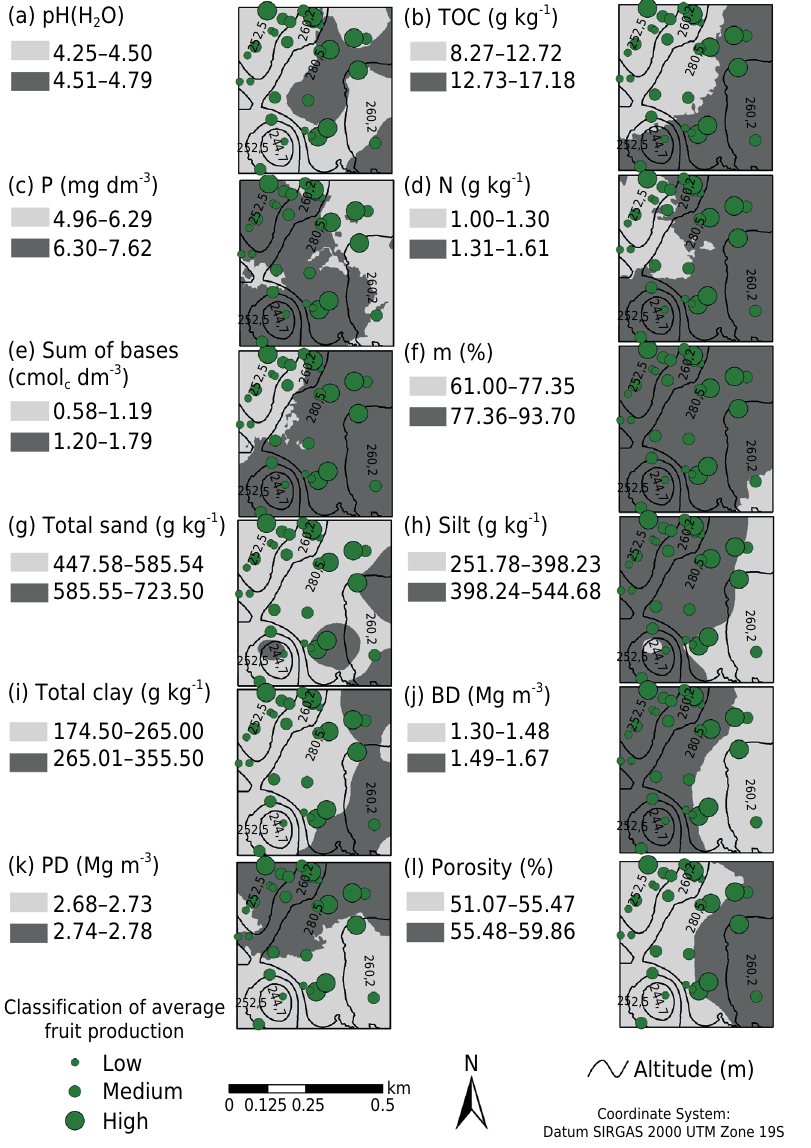
Figure 5. Spatial distribution of soil physical and chemical properties in Cachoeira - Plot 2, in the state of Acre, Brazil. Lines and values in the maps correspond to the altitude of the area, circles correspond to the average fruit production between the years 2010 and 2020, and values presented in the legends are the soil